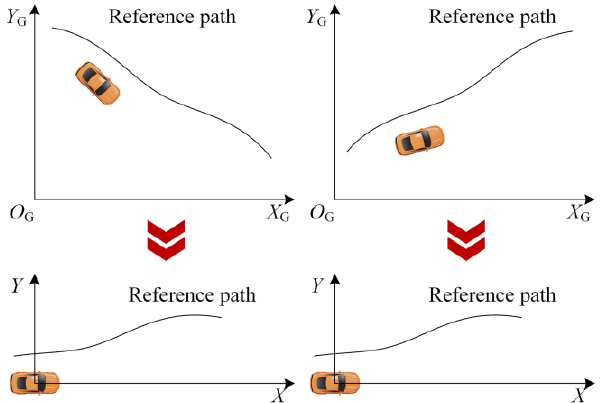
Figure 1. The schematic diagram of the reference path in different coordinate